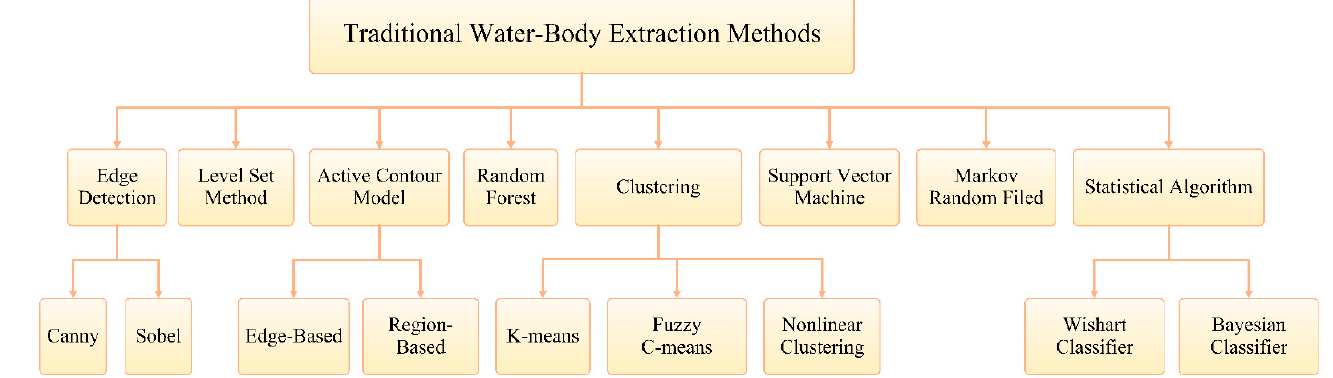
Figure 2. Traditional water body extraction methods for SAR images.